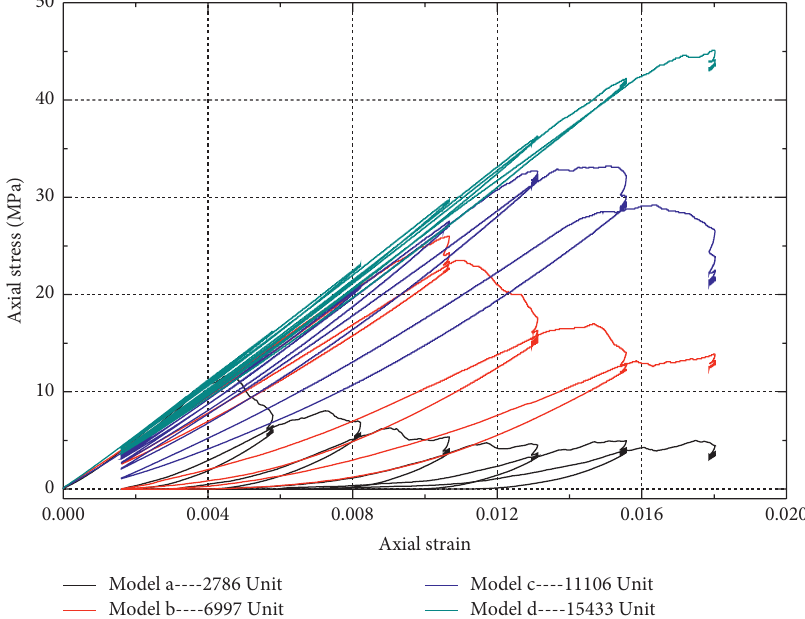
Figure 17: Stress-strain curves of coal sample with different particle Figure 20. In the preload period, the load/unload response ratio Y is always maintained at about 1. As the stress ap- proaches its peak, the Y value increases abruptly, as shown by the response at the last cycle level of models a and d in Figure 20. The Y value fluctuates more at the peak and even becomes negative.